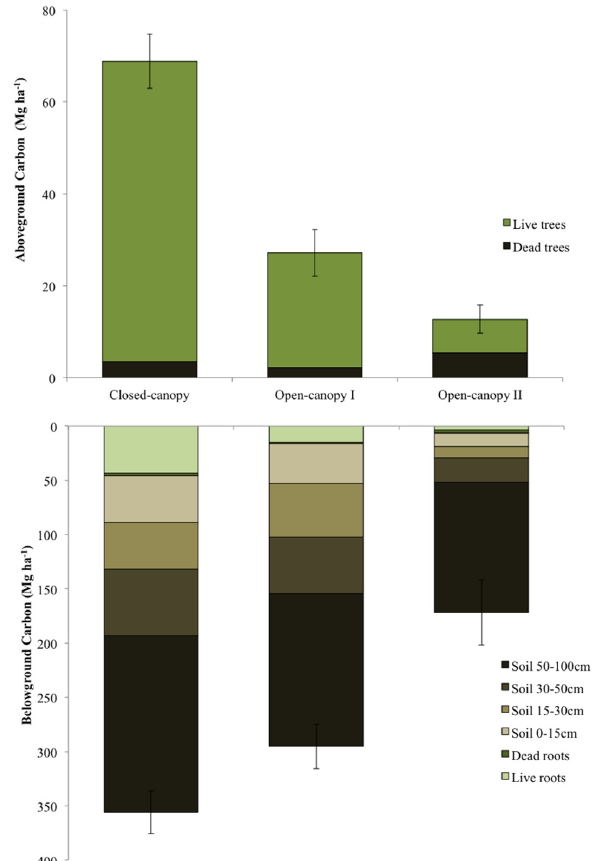
Figure 10. Total vegetation carbon and soil organic carbon stocks for the Ambaro-Ambanja Bays, Northwest Madagascar. Error bars represent ± SE of total carbon stocks. Adapted from Jones et al. [62] with permission of Springer).